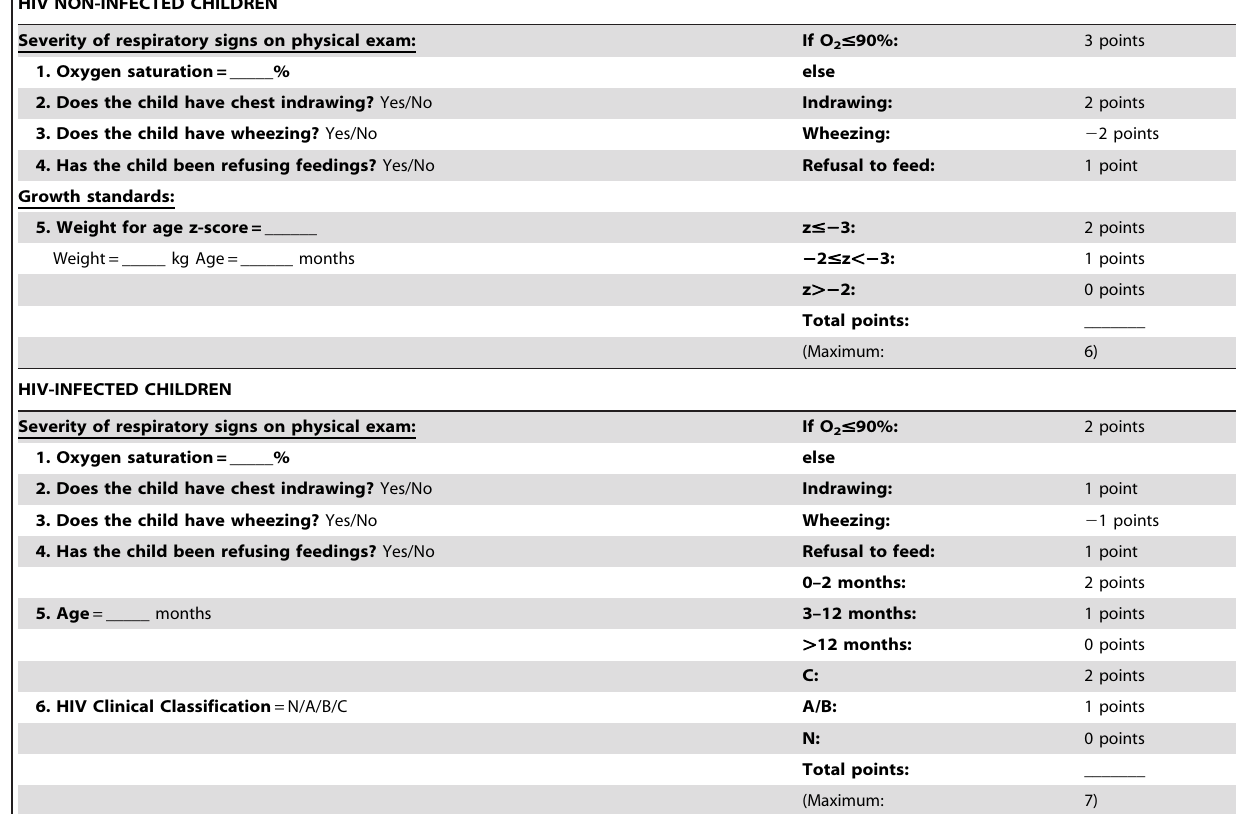
HIV NON-INFECTED CHILDREN Severity of respiratory signs on physical